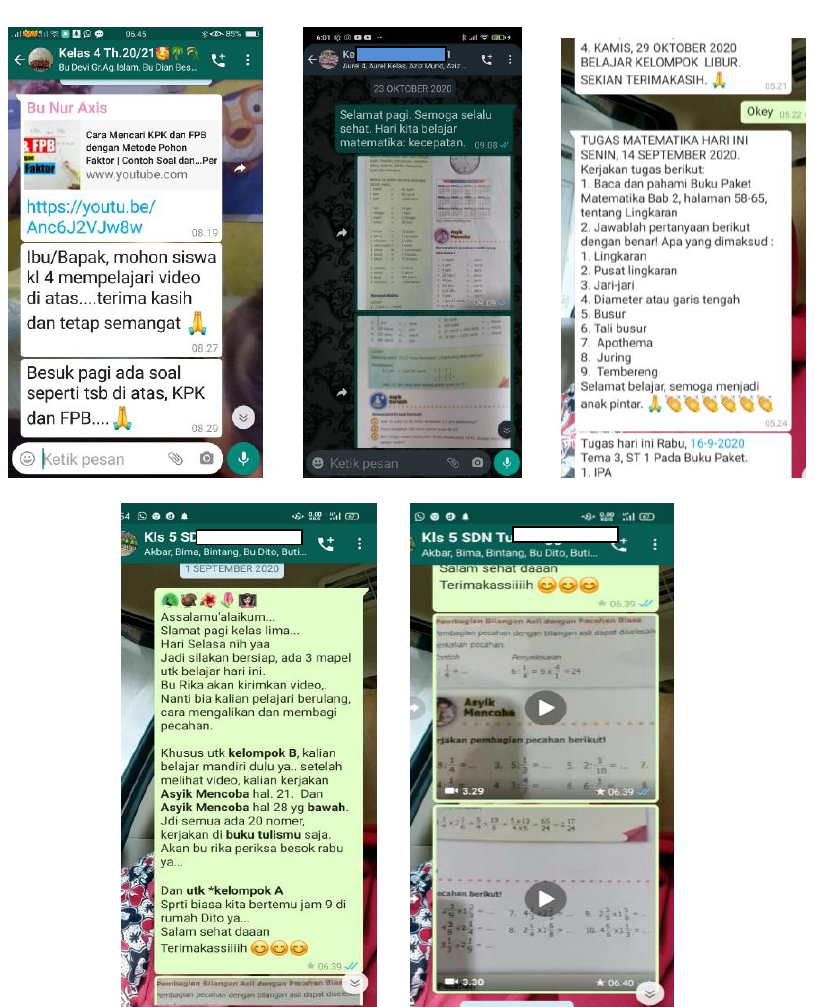
Figure 1. Example of an assignment discussion during online Mathematics